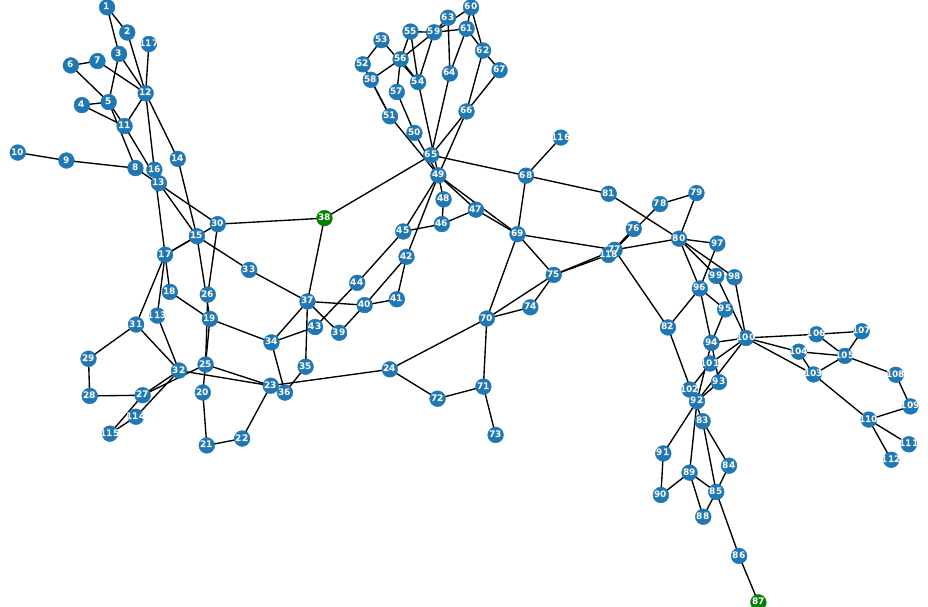
Figure 10. The 2 × 75 MW demand location during seasons 1, 2, and 3 without mobile MSSSC. Green node indicates the load connection location.